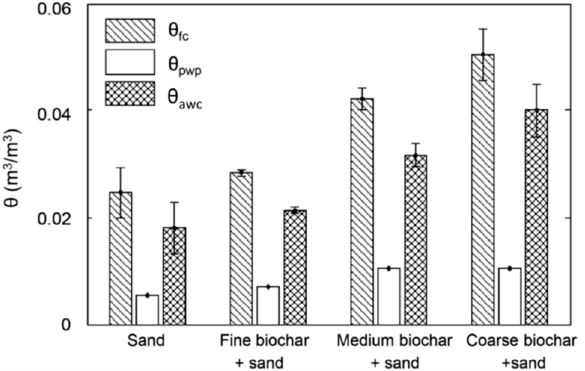
Figure 5. Field capacity ( θ fc ), permanent wilting point ( θ pwp ), and plant available water content ( θ awc ) of sand, and three biochar–soil mixtures [32]. Reprinted from the reference with the permission, © 2021 Liu et al., CC-BY-4.0.